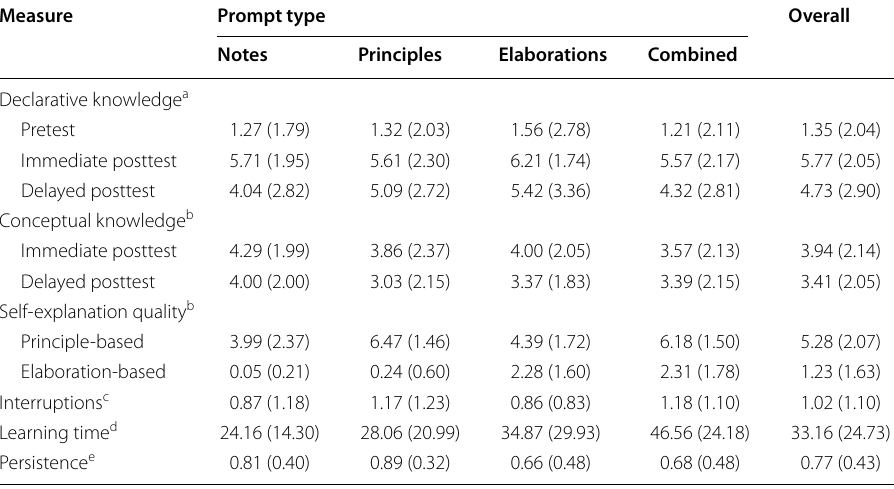
a Score from 8 (minimum) to 8 (maximum) − b Scale from 1 ( very low quality ) to 8 ( very high quality ) c Scale from 0 ( no interruption ) to 4 ( more than three interruptions ) d Time in minutes e Dichotomous (1: took part in the delayed posttest; 0: did not take